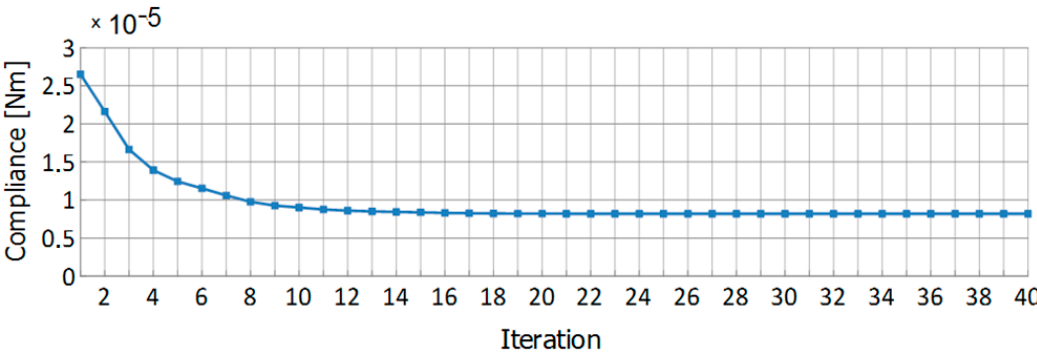
Figure 19. The iteration history for the cantilever structure.